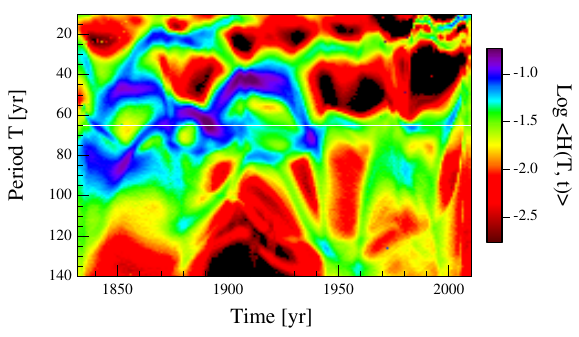
Fig. 6. Ensemble averaged Hilbert Spectrum h H ( T,t ) i reported in the time-period plane. The horizontal white line indicates the 65 yr characteristic periodicity.